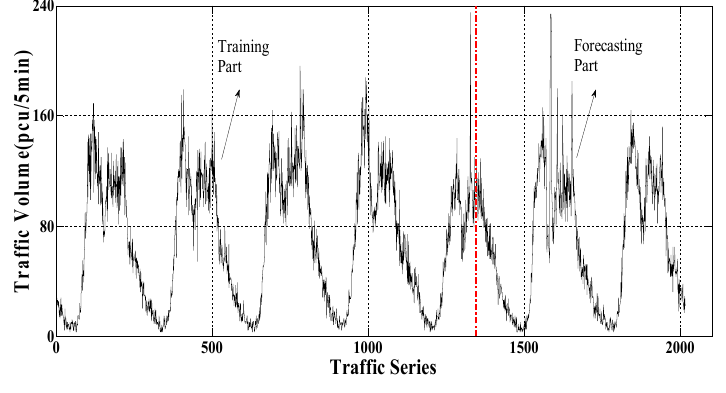
Figure 6. Traffic volume time series (B) . Figure 6. Tra ffi c volume time series (B). Table 3. Data characteristics (B). Table 3. Data characteristics (B).